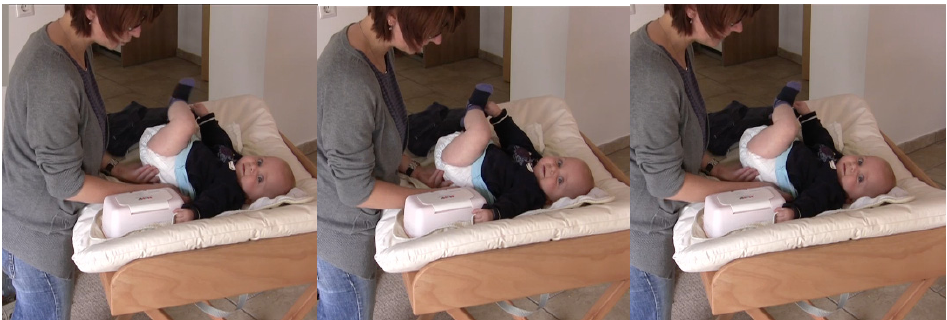
Figure 5. A mother subsequently commenting on her action.